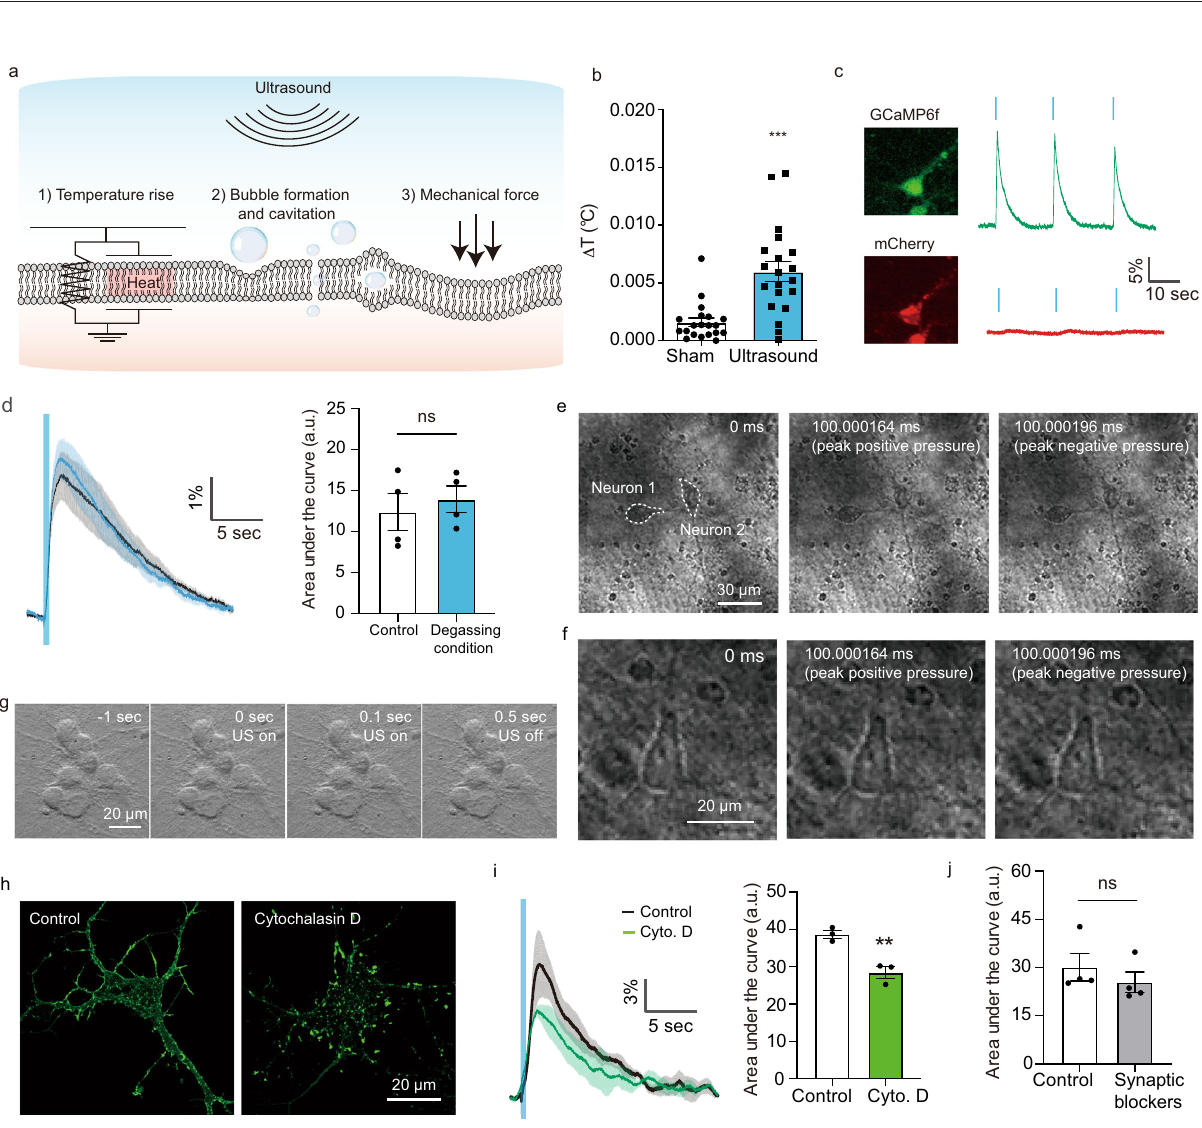
Fig. 2 Ultrasound excites neurons through direct mechanical effects. a Illustration of the potential biophysical effects of ultrasound. b Temperature increase measured using an optic hydrophone thermometer positioned near the neurons during ultrasound stimulation ( n = 20, 15 W/cm 2 , 500 ms pulse duration with 20 s inter-pulse interval, Unpaired T -test, two-tailed, p < 0.0001). c Fluorescence images of a neuron co-expressing GCaMP6f (green) and mCherry (red) and changes in their respective fl uorescence in response to ultrasound stimulation. d Calcium responses to ultrasound in freshly degassed media ( n = 4 independent experiments each, unpaired t -test, two-tailed, p = 0.6033). e Ultra-high-speed imaging (5 Mfps) of neurons and surrounding media during ultrasound stimulation. Image recording was started 100 ms after the onset of ultrasound. f Ultra-high-speed imaging of a single neuron during ultrasound stimulation at higher magni fi cation. g Bright fi eld imaging of neurons over the full time course of the ultrasound stimulation. h Images of individual neurons with the F-actin label Alexa-Fluor 488 phalloidin before and after treatment with cytochalasin D. i Calcium responses before and after cytochalasin D treatment, and quanti fi cation of area under the curve ( n = 3 independent experiments, unpaired t -test, two-tailed, p = 0.0061). j Quanti fi cation of area under the curve after applying the synaptic blockers AP5 and CNQX (1 μ M each, n = 4 independent experiments, paired T -test, two-tailed, p = 0.4128). Mean trace is solid and SEM is shaded. Bar graph values represent mean ±